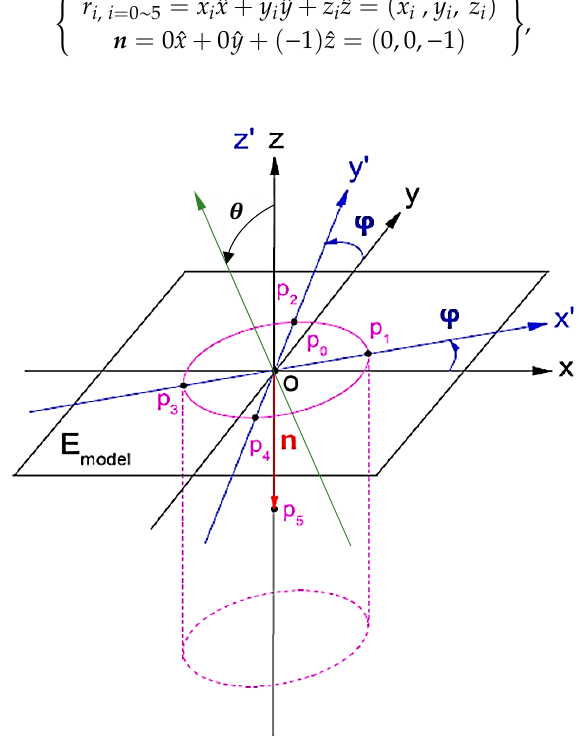
Figure 1. Single circular column array.